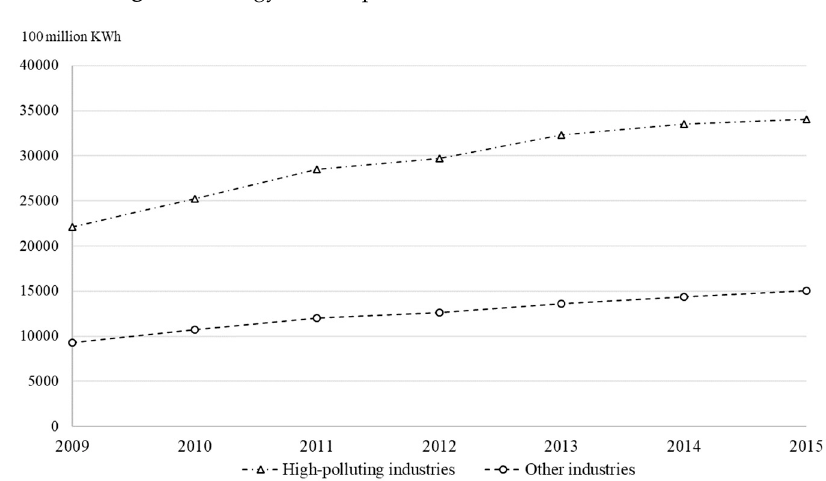
Figure 2. Electricity consumption of different industries in China.